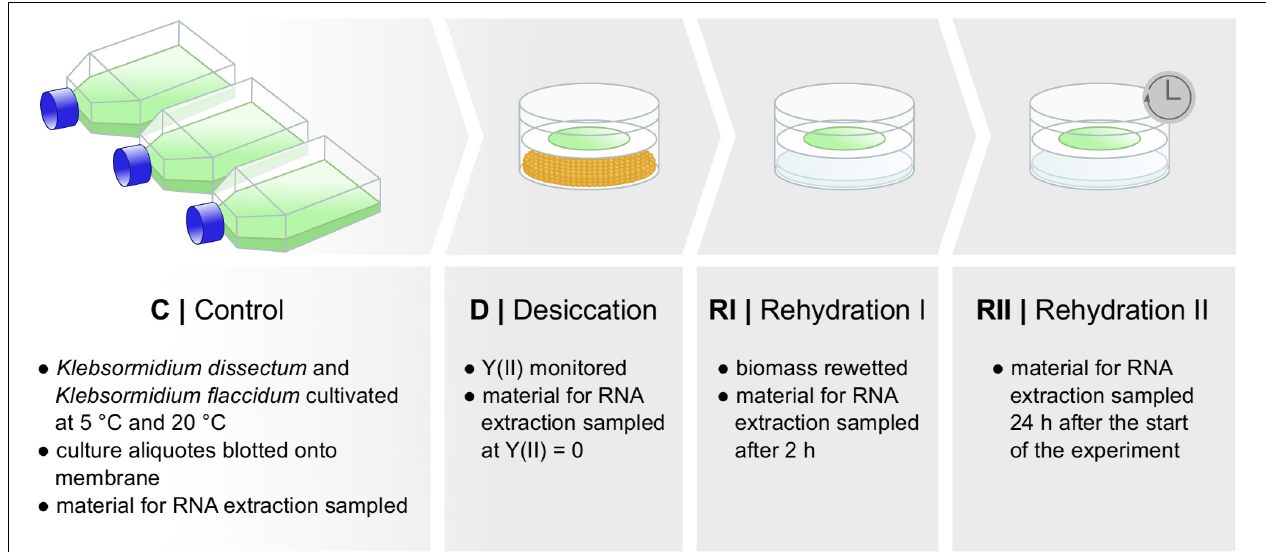
FIGURE 2 | Experimental set up. Two different species of Klebsormidium were desiccated at two different temperatures [5 and 20 ◦ C until Y(II) reached zero] for the time indicated in Figure 3 and allowed to recover for 2 h and approximately 24 h. Samples were taken at several time points for control, desiccation treatment, and during the recovery phase. RNA was subsequently